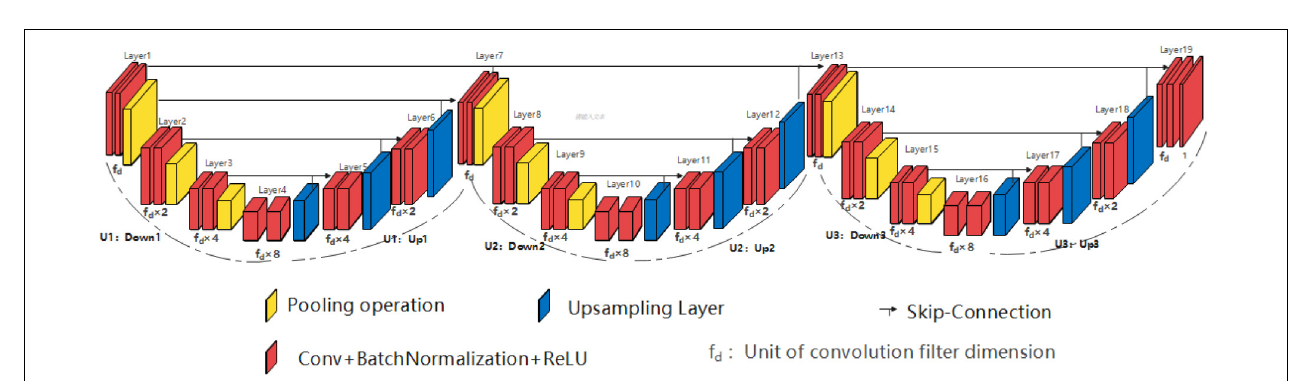
FIGURE 3 | Structure diagram of single low peak horizontal EUNet (SLP-horizontal EUNet) U 1 (4-3)-U 2 (3-4).